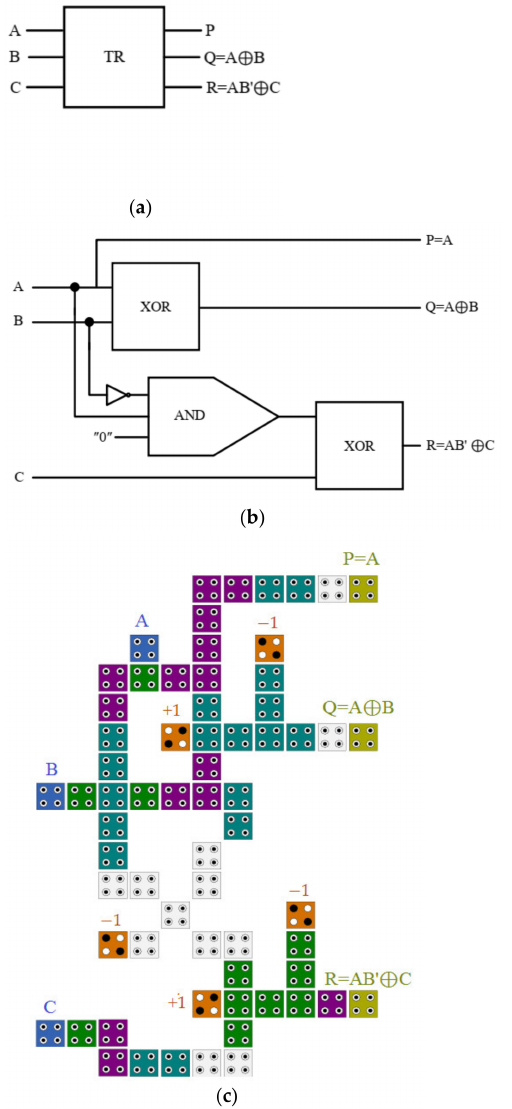
Figure 10. TR gate ( a ) logic diagram, ( b ) block diagram, and ( c ) QCA